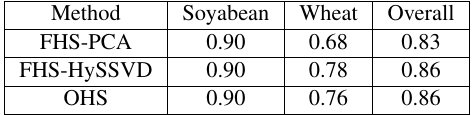
Figure 7: Spectral Signatures of class Soyabean and Wheat Method